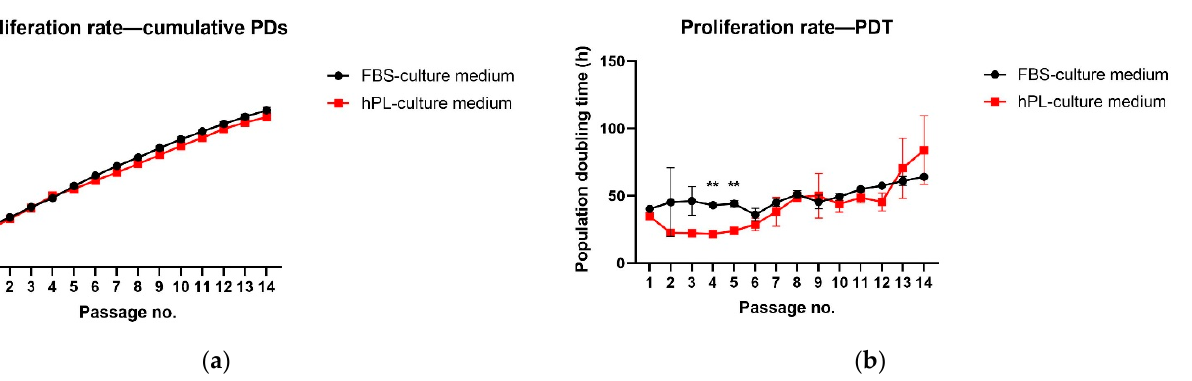
Figure 2. The proliferation rate of hNDP-SCs. The first passage was considered the initial for comparing hNDP-SCs grown in two different media. The data are presented as the mean ± SD. The Shapiro–Wilk test or Kolmogorov–Smirnov test were used for normal distribution evaluations. The statistical significances (** p < 0.01) were calculated using the paired t -test: ( a ) Cumulative populations doubling; ( b ) Population doubling time in hours.